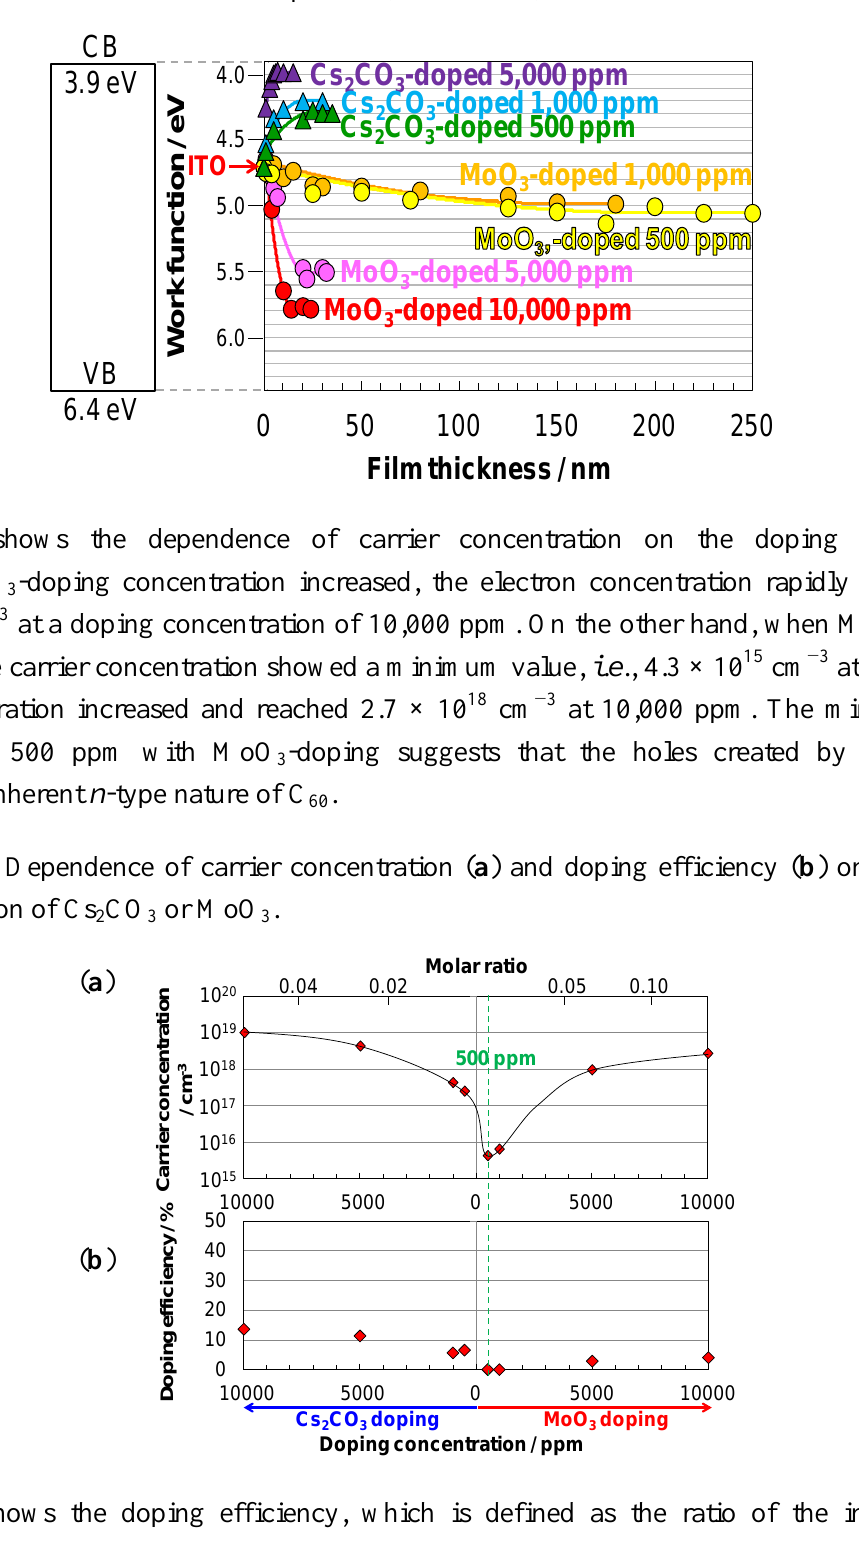
films doped with Cs 60